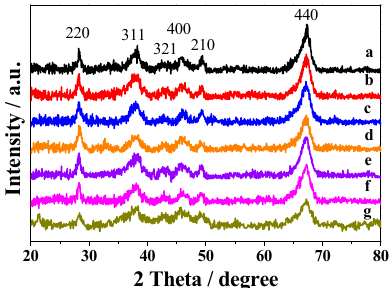
Figure 1. XRD patterns of: ( a ) Al 2 O 3 ; ( b ) Ru/Al 2 O 3 -H 2 ; ( c ) Ru/Al 2 O 3 -NaBH 4 ; ( d ) Ru/Al 2 O 3 -air; ( e ) five-times used Ru/Al 2 O 3 -H 2 ; ( f ) five-times used Ru/Al 2 O 3 -NaBH 4 ; ( g ) five-times used Ru/Al 2 O 3 -air